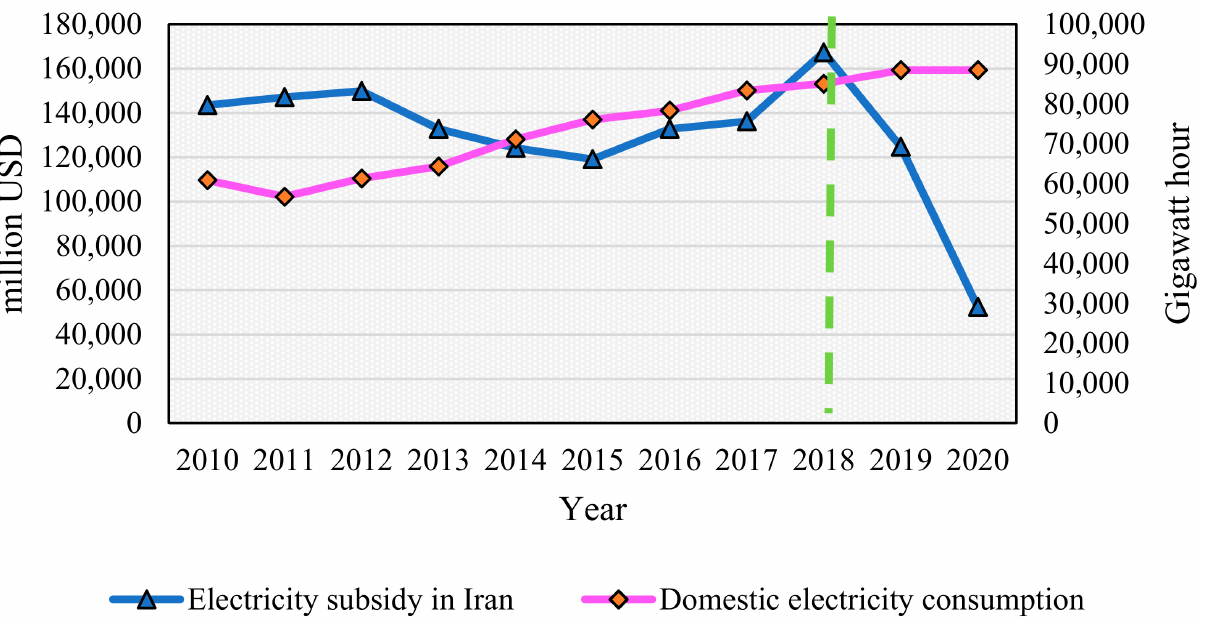
Figure 29. The electricity subsidy for Iran and the effect on domestic electricity